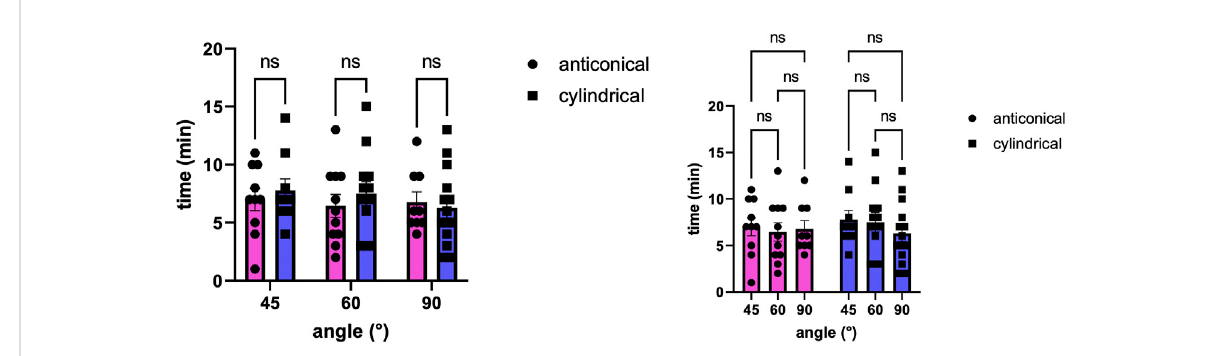
FIGURE 4 Time per hole by geometry and angulation.